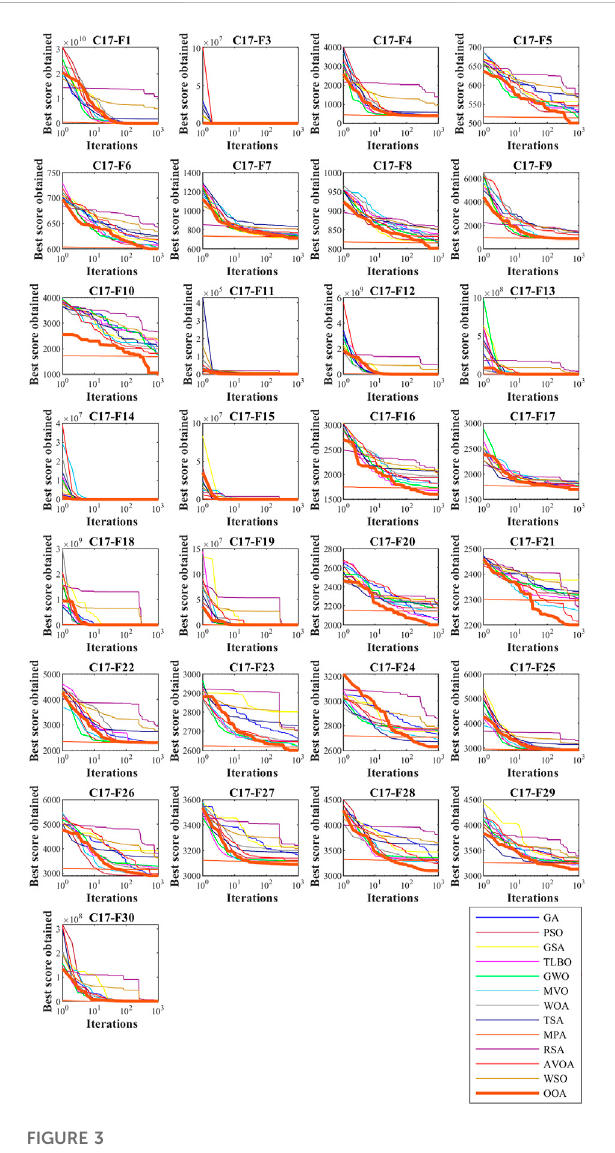
FIGURE 3 Boxplot of OOA and competitor algorithms in optimization of the CEC-2017 test suite (D =